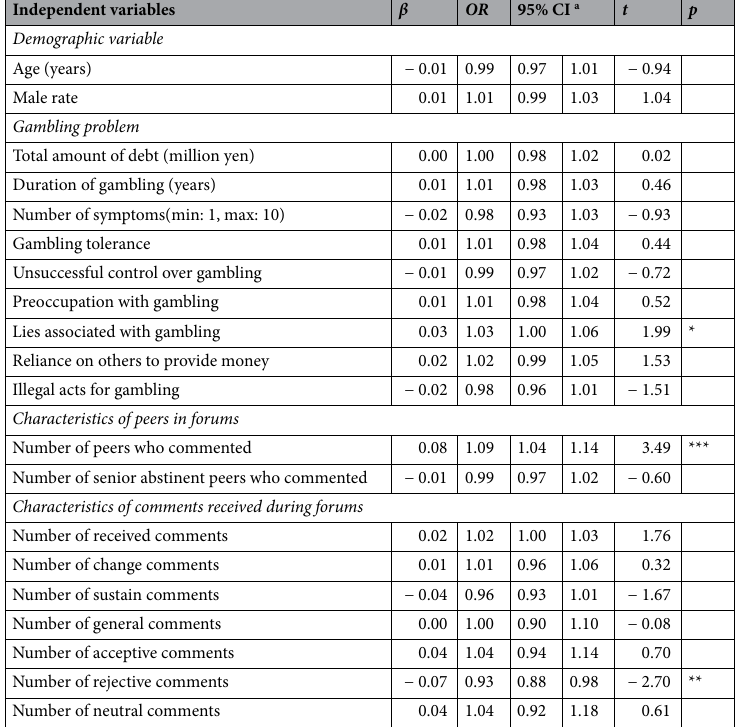
Table 2. Predictive values on abstinent gamblers through Partial Least Squares Regression. The number of Partial Least Squares (PLS) components was set as four based on the simulation (Supplementary Fig. 4). The dependent variable was abstinent gamblers for 3 years (yes: 1, no: 0). All independent variables were standardized. The area under the receiver operating characteristic curve was 0.701. The coefficient of determination was 0.107. The following gambling problems were not included as independent variables because consistency between the two raters and the psychologist was low: gambling withdrawal, gambling as problem avoidance, chasing one’s gambling loss, and loss of relationships and opportunities. CI: Confidence Interval, OR: adjusted odds ratio, a : The 95% confidence intervals in this study are estimates because I used a pseudo-inverse matrix rather than an inverse matrix when calculating the standard errors of the regression coefficients, * p < 0.05, ** p < 0.01, *** p <